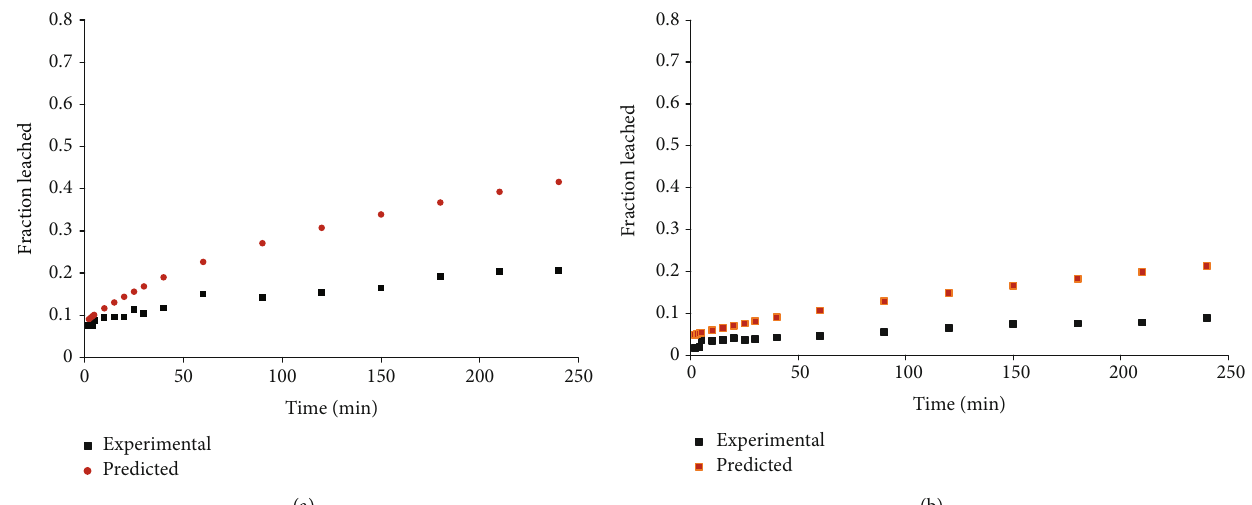
Figure 10: Experimental and predicted fraction of potassium leached from potato (a) spheres preheated and leached at 35 ° C and (b) cubes preheated and leached at 30 °